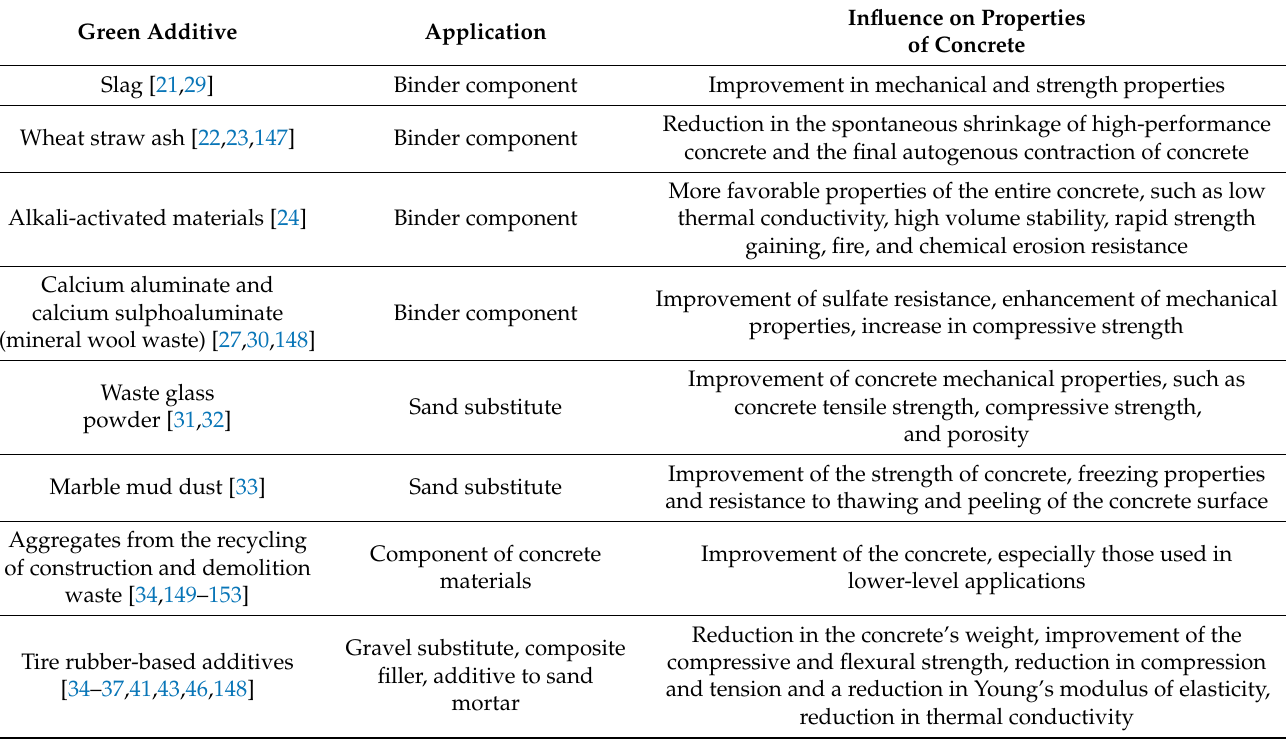
Table 4. The types of additives used for the production of green concrete, based on